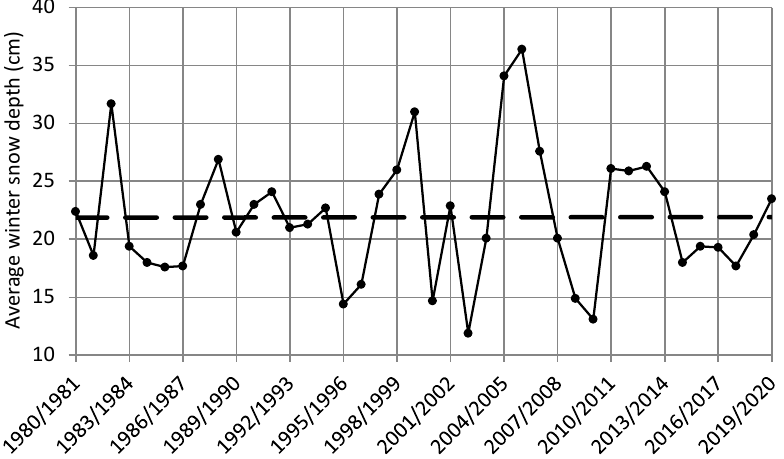
Figure 6. Long-term variability of mean winter snow depth in Yakutsk. The dashed line is the linear trend.